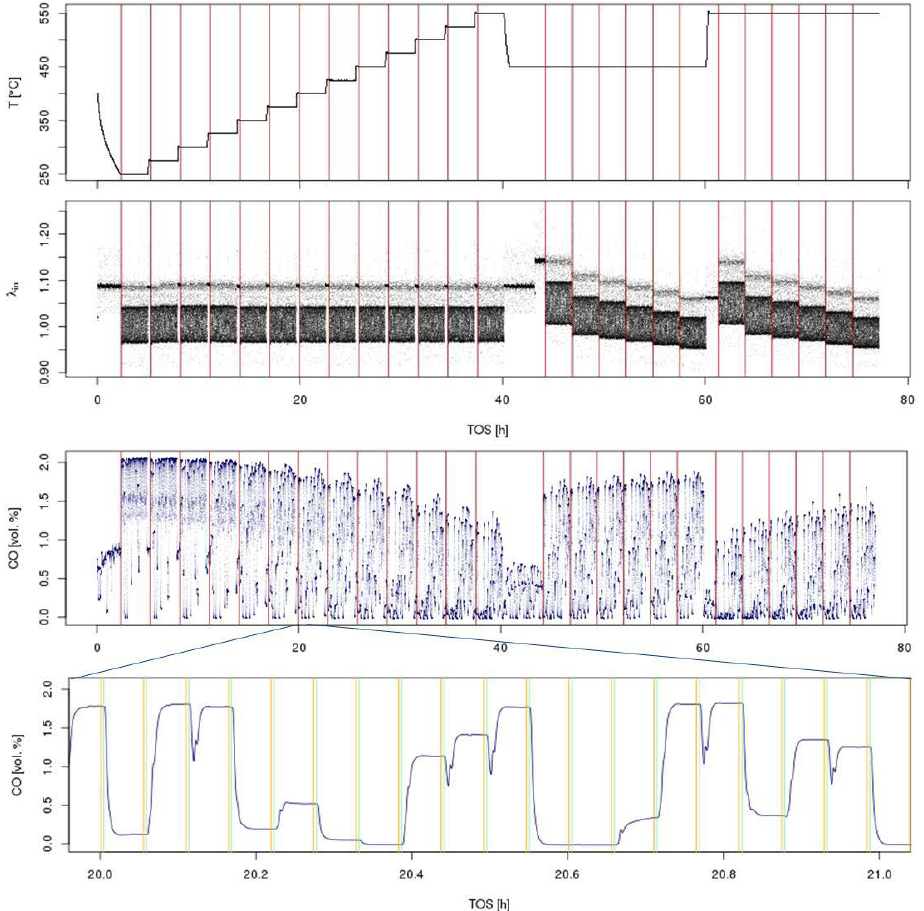
Figure 4. Overview of time-resolved sensor readings from a typical three-way catalyst screening in a simulated gasoline engine exhaust with λ perturbation. The test involves a light-off at λ = 1 at T = 250– 550 °C in 25 °C steps followed by a λ sweep at T = 450, 55 0 °C at 6 different λ values, 1.05, 1.02, 1.01, 1.0, 0.99, 0.98, in the sequence from lean to rich (top: temperature and λ traces; bottom: CO concentration for the whole experiment + zoom into a shorter time interval). Vertical lines in the top three graphs indicate a change in experimental conditions ( T or λ); in the bottom graph, they indicate the averaging interval for each reactor position. Throughout the whole experiment, >270,000 data points are collected for each individual sensor.